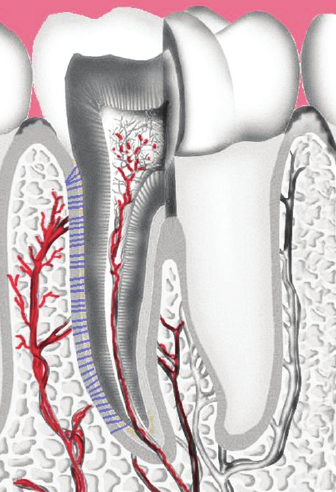
Figure 2: Vascularisation of the dental pulp and the alveolar